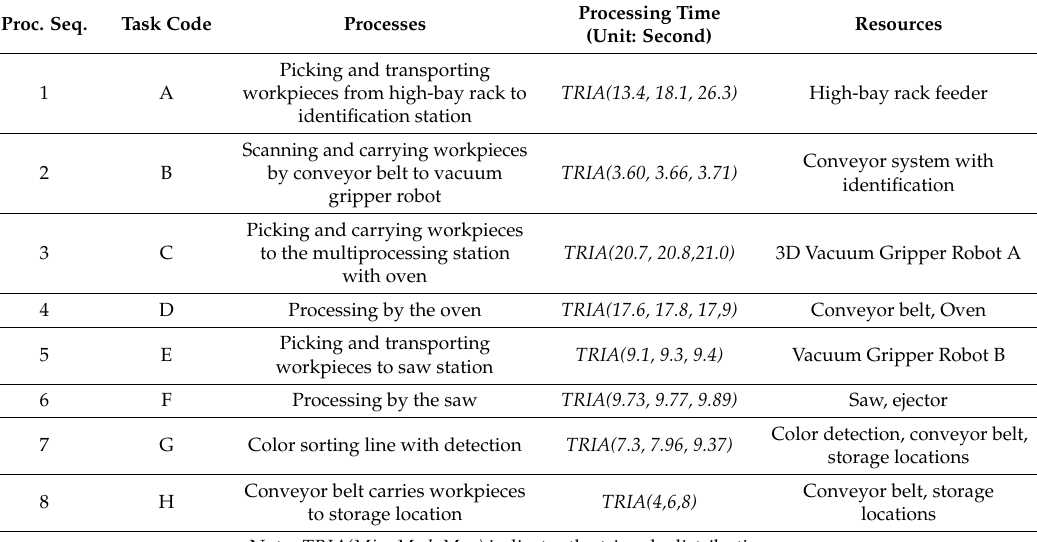
Table 1. Process schedule and processing parameters in the factory model.